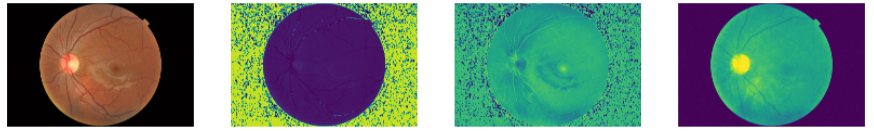
Figure 2. Apparently good quality RFI and its three channels in HSV color space. The background noise can be seen, which is mostly associated with image compression.